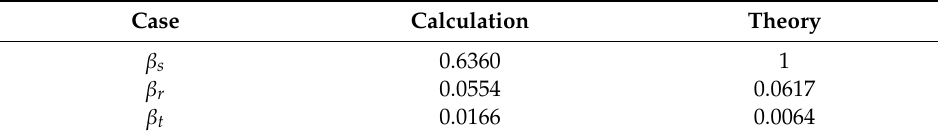
Table 2. Reflection and transmission coefficients for entropy wave frequency Case